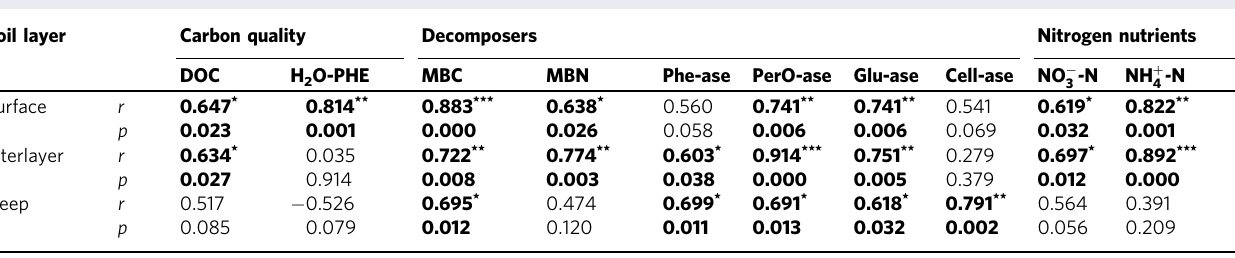
Table 2 Correlations between soil CO 2 emission and soil variables at each layer ( n =